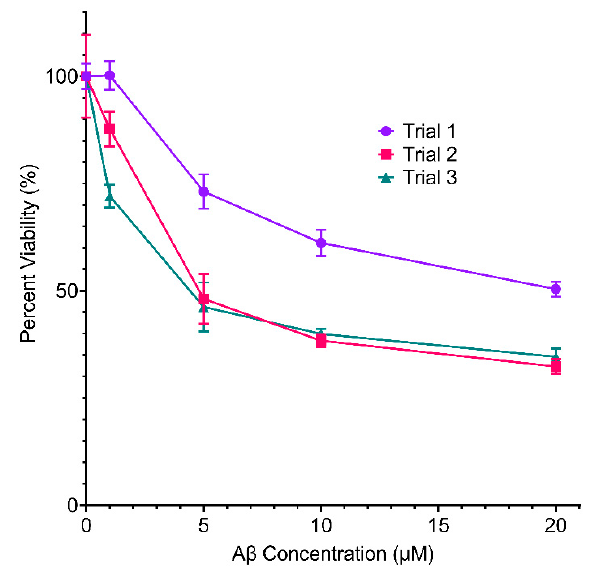
Figure 4. Effect of varying concentrations of A β 1–42 on the viability of primary neurons. Viability of mouse primary cortical neurons was measured by MTT assay in three separate trials. Points represent the mean of six replicates, and error bars represent standard deviation. Molecules 2021 , 26 , x FOR PEER REVIEW